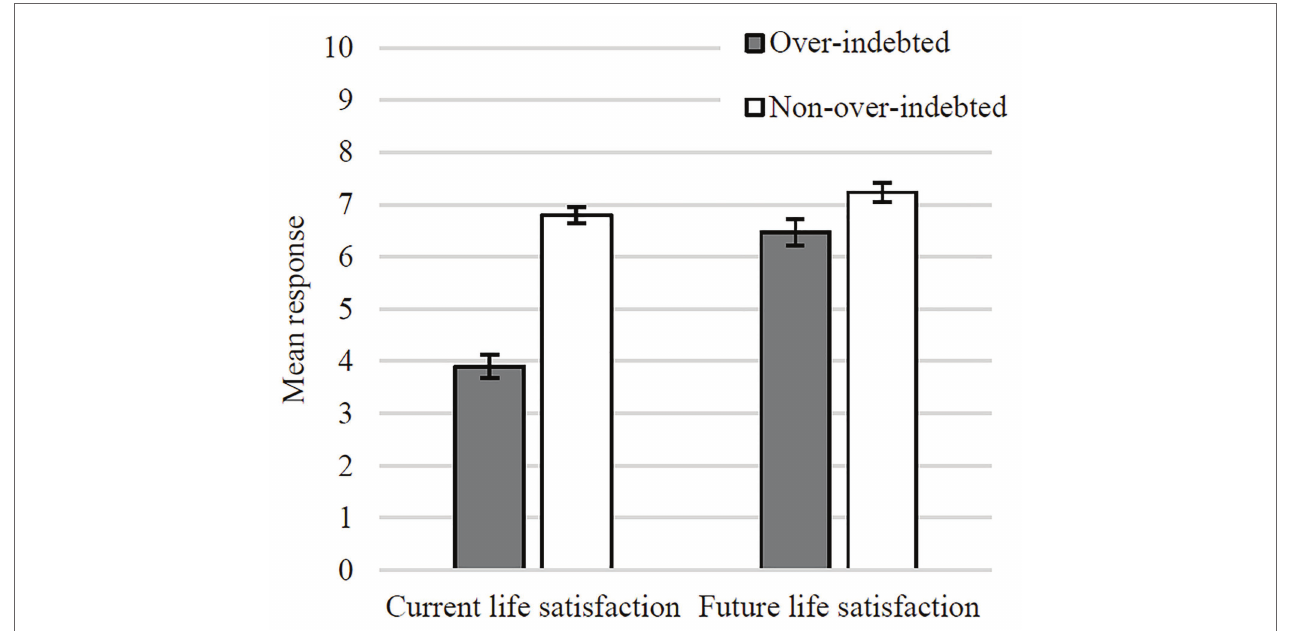
FIGURE 1 | Mean evaluations of current and future life satisfaction (with SEs) in over-indebted and non-over-indebted